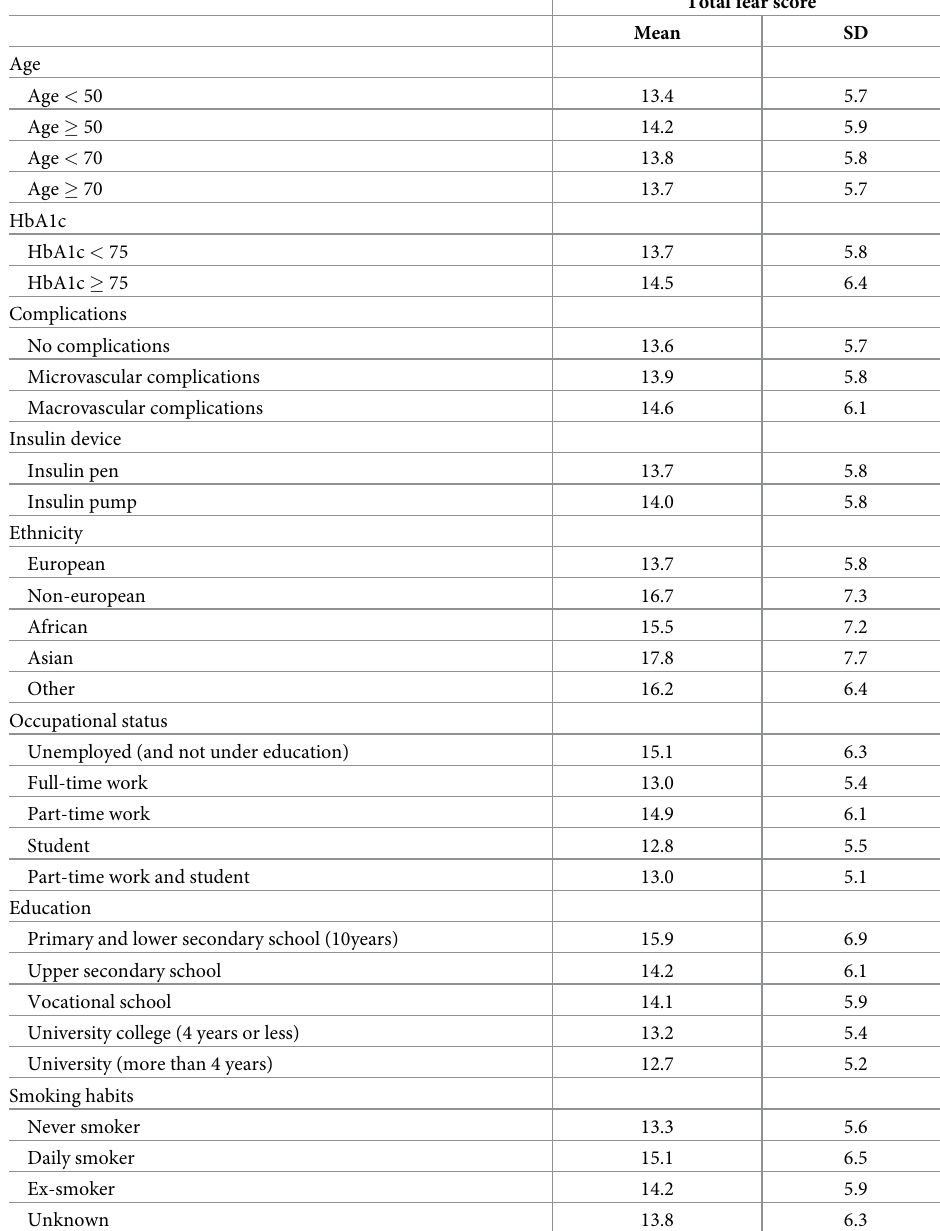
Table 2. Showing total fear score in the different patient